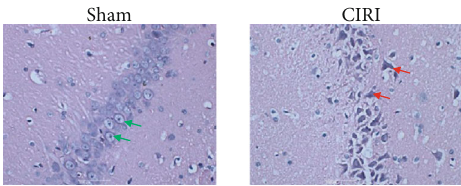
Figure 1: Histopathological changes in hippocampus tissues of rats in the sham and CIRI group were observed by H&E staining. Green arrows point to living cells; red arrows point to dead cells. Magni fi cation ×